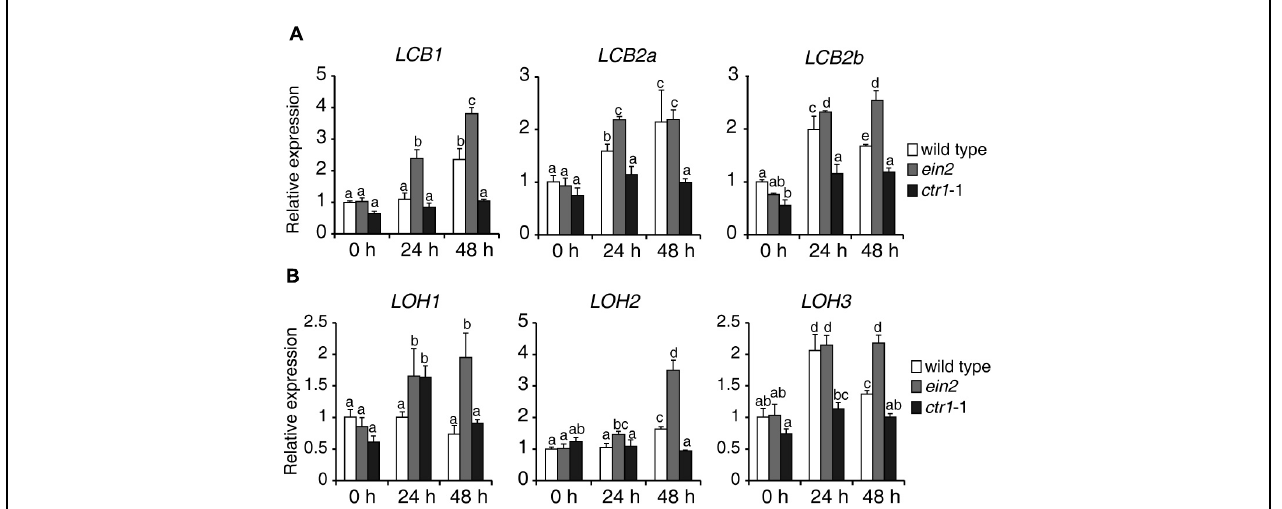
FIGURE 6 | Expression of genes involved in de novo sphingolipid synthesis in wild-type, ein2 , and ctr1 -1 seedlings during FB1 treatment. Seven-day-old seedlings were treated with 0.5 µ M FB1 and samples were collected at the indicated times. ACT2 (AT3G18780) was used as an internal control. Gene expression values are presented relative to average wild-type levels, which were set as 1. Data represent means ± SD from three technical repeats and sets marked with different letters indicate significances assessed by Student–Newman–Keul test ( P < 0.05). This experiment was repeated three times with similar results. The primers used for this analysis are provided in Supplementary Table S1. (A) Relative transcript abundance of genes involved in LCB synthesis ( LCB1 , LCB2a , LCB2b ). (B) Relative transcript abundance of genes involved in ceramide synthesis ( LOH1 , LOH2 , LOH3